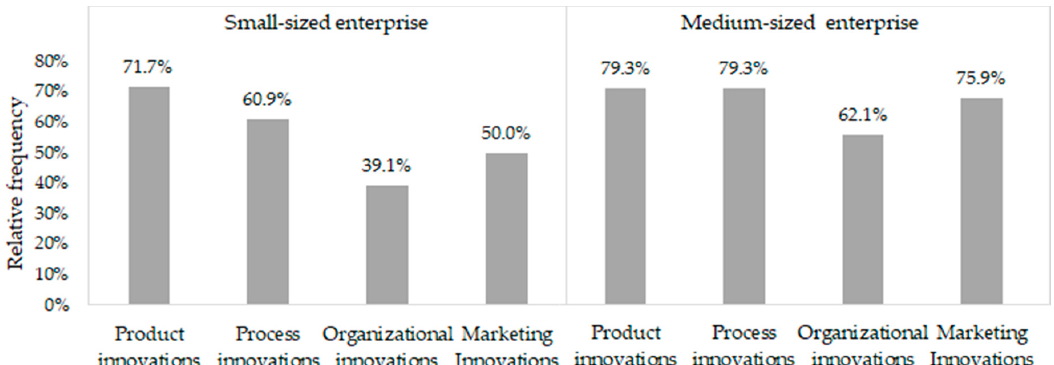
Figure 2. The relative frequencies of the number of types of introduced innovations grouped by the size of the company.